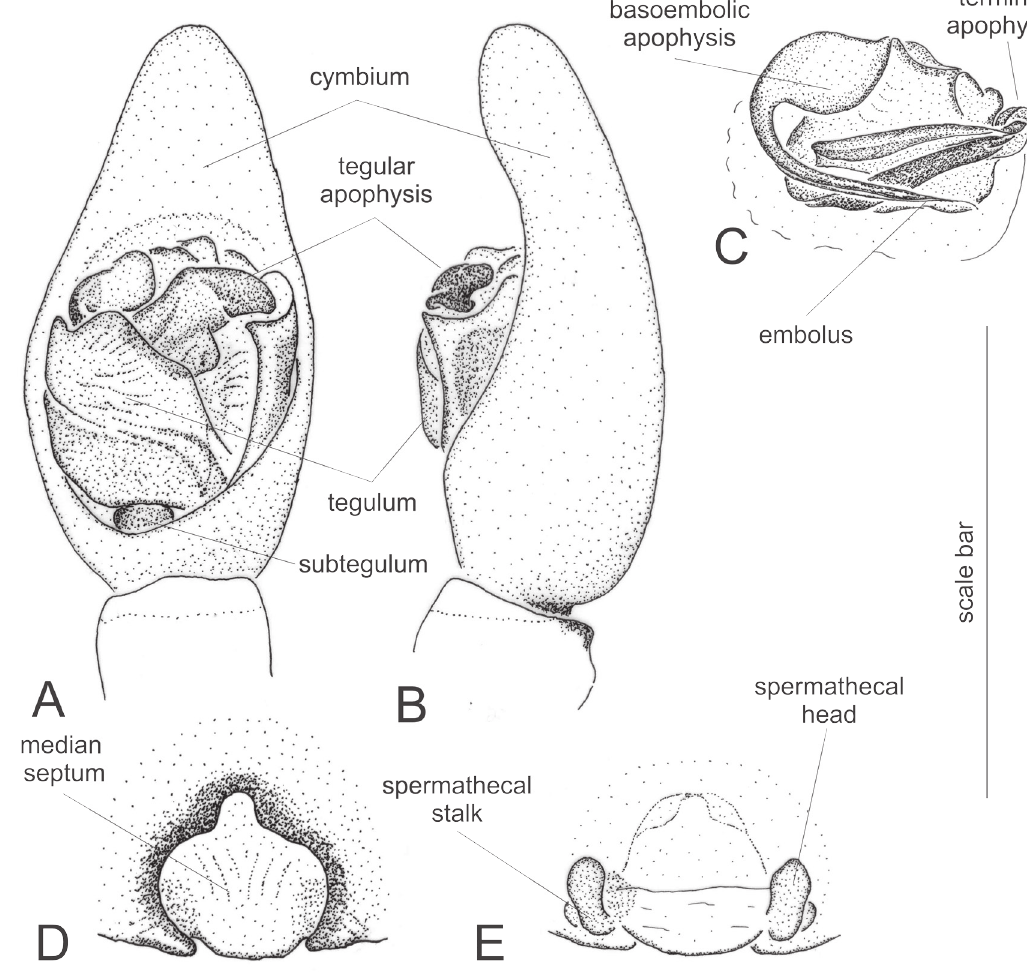
Fig. 24. Tetralycosa eyrei (Hickman, 1944), ♂ (SAM NN21737) and ♀ (SAM NN13814). A–B . Left male pedipalp, ventral and retrolateral view. C . Left male pedipalp, palea section of bulbus, ventral view. D–E . Female epigyne, ventral and dorsal views. Scale bar: A–B = 1.89 mm; C = 1.23 mm; D–E = 1.26